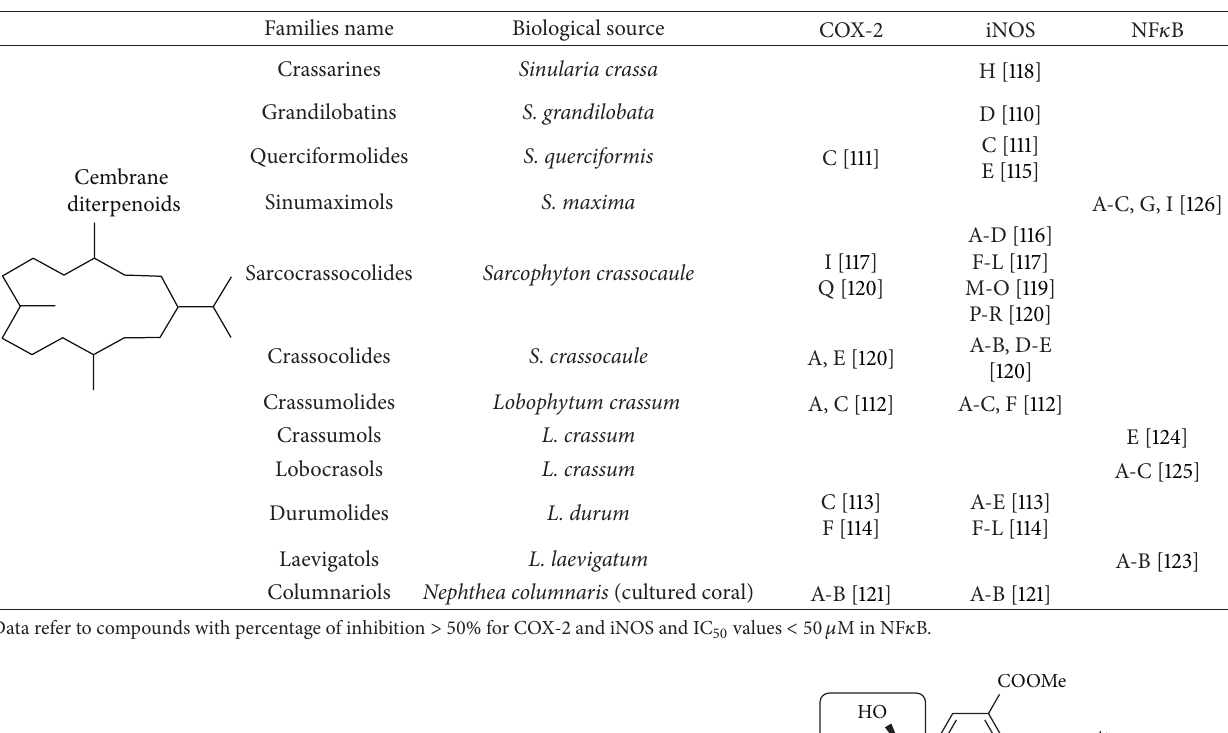
Table 3: Anti-inflammatory effect of cembrane diterpenoids.